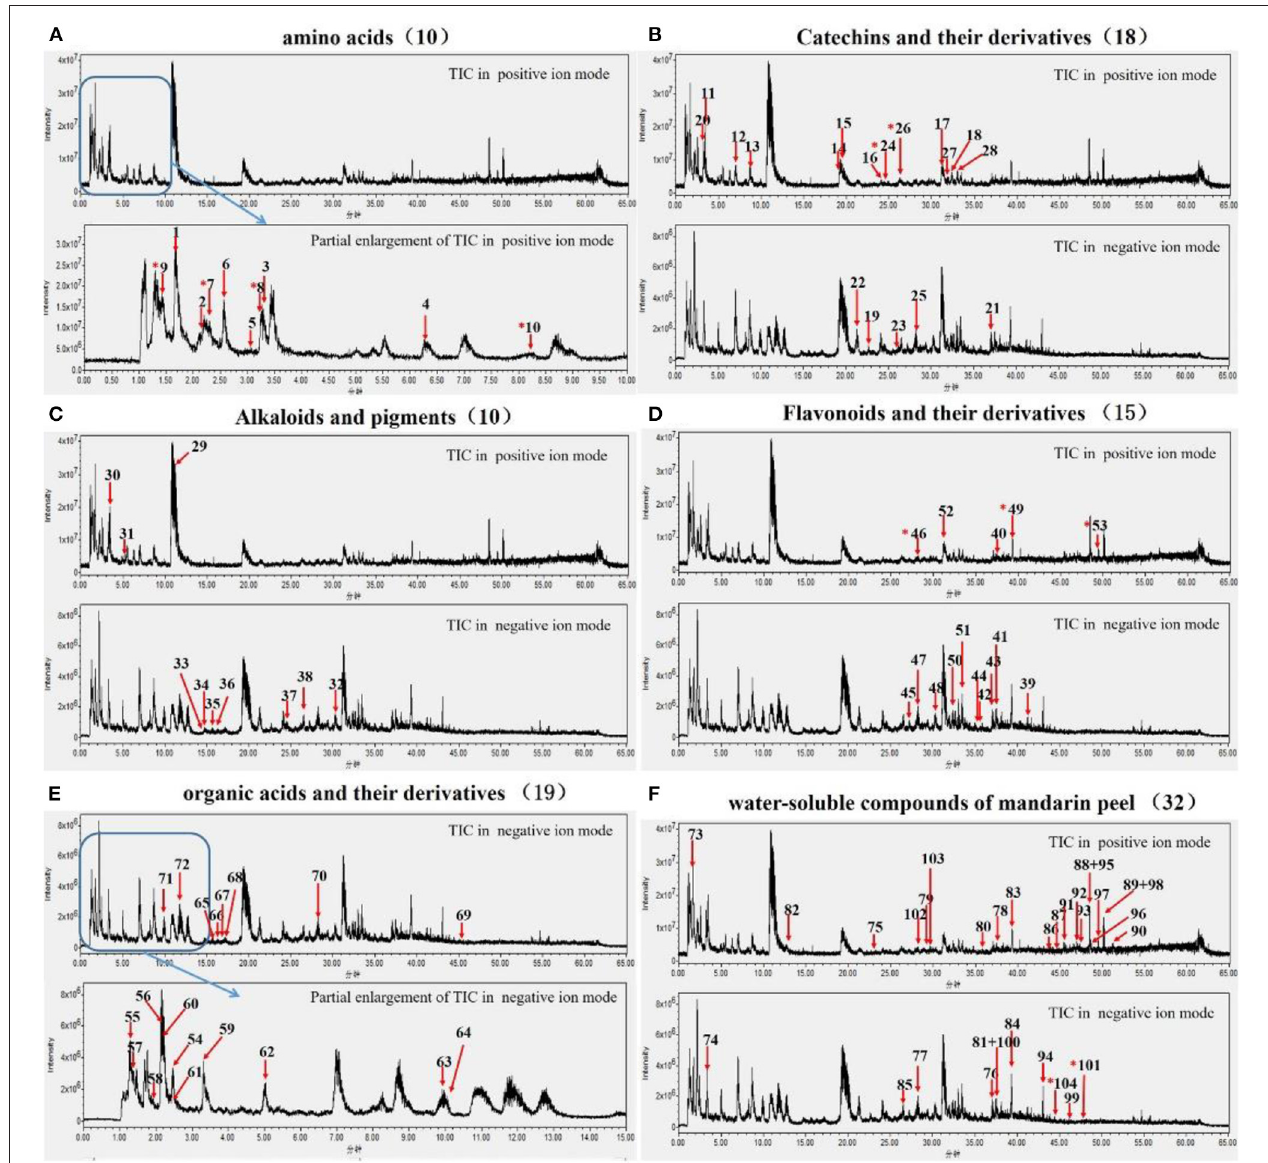
FIGURE 2 | Flavor substances of Ganpu tea were identified by UPLC-Q-TOF system in different categories, including ten amino acids (A) , 18 catechins and their derivatives (B) , three alkaloids and seven pigments (C) , 15 flavonoids and their derivatives (D) , 19 organic acids and their derivatives (E) , and 32 water-soluble compounds of mandarin peel (F) ,